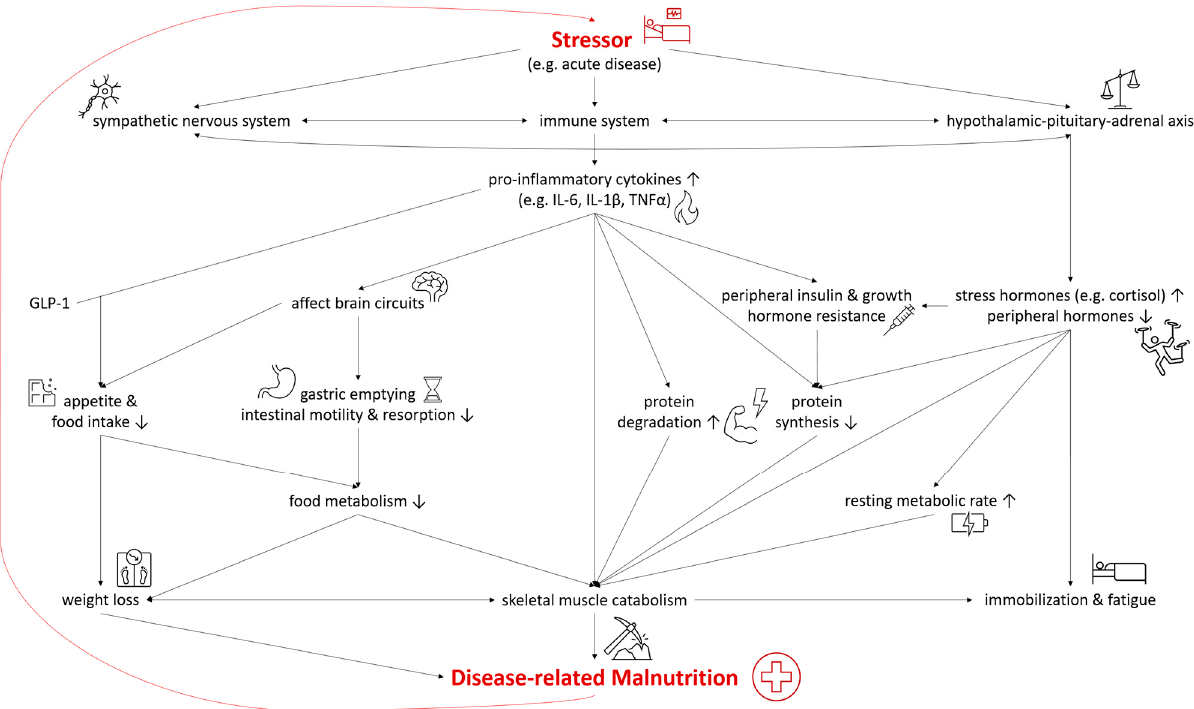
Figure 2. Selected Pathways in the Interplay of Inflammation and the Pathophysiology of Disease- related Malnutrition. IL-6, interleukin 6; IL-1 β , interleukin 1 β ; TNF- α , tumor necrosis factor α ; GLP-1, glucagon-like Peptide-1.